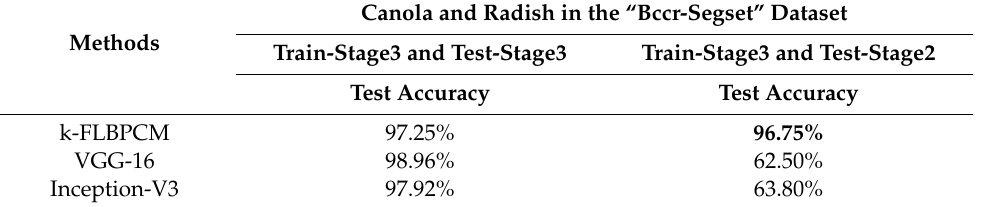
Table 6. Comparison of the classification accuracies of methods in the use of canola and radish plants at di ff erent growth stages in the “bccr-segset”